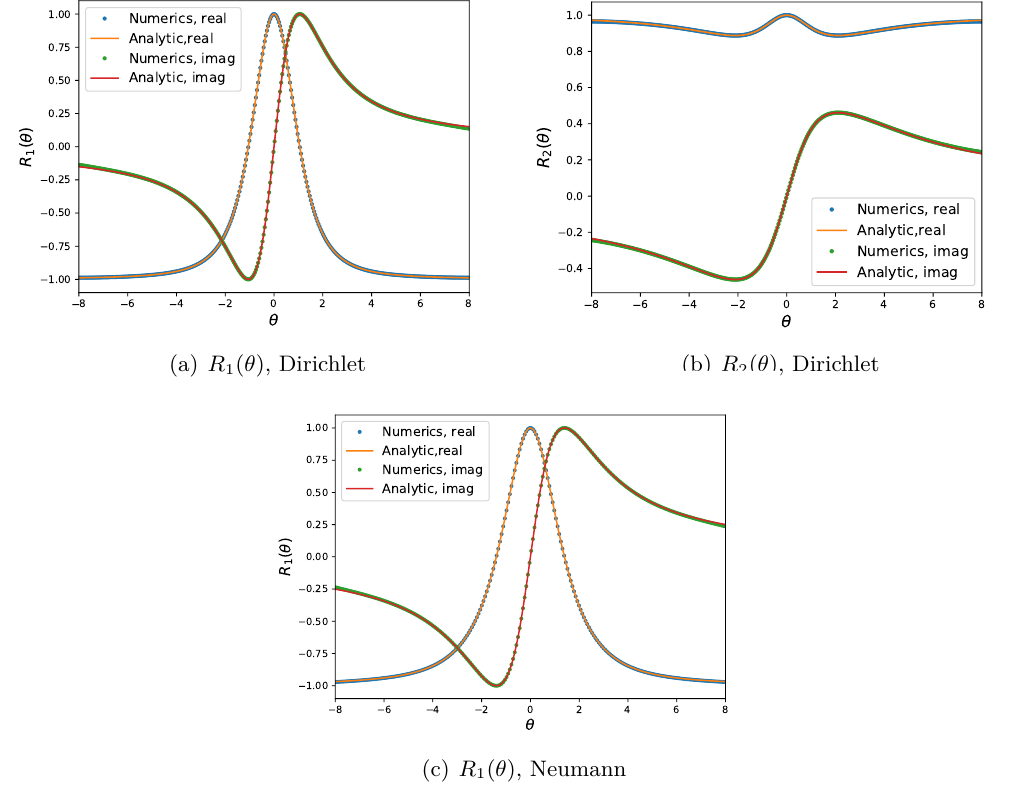
Figure 5 . Plot of R 1 ( θ ) and R 2 ( θ ) on the real axis. Figures (a) and (b) correspond to the red dashed vertex of figure 4. It agrees precisely with Dirichlet R-matrix. Figure (c) is the purple dashed vertex of figure 4 and agrees with the Neumann R-matrix.